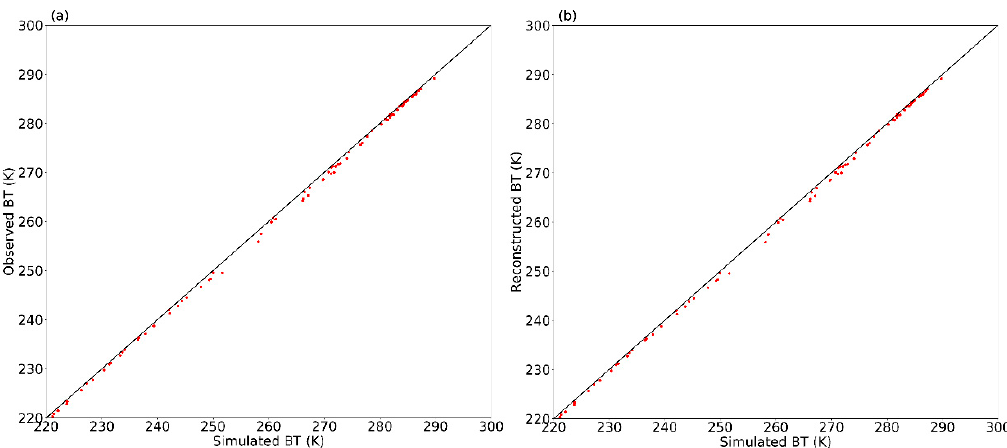
Figure 13. Scatterplot of ( a ) the observed BT against the simulated BT and ( b ) the reconstructed BT against the simulated BT during typhoon Mangkhut.